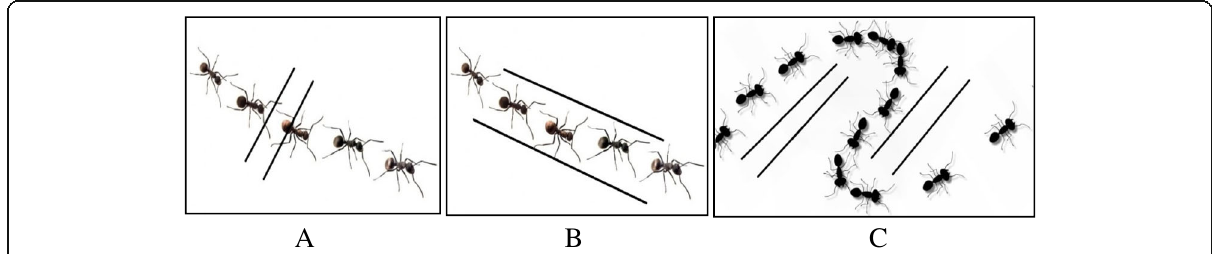
Fig. 4 Scenarios in the ant-rout experiment. Three scenarios of the ‘ ant-rout ’ experiment for predicting rains (parallel lines are artificially constructed ditches). a Ants cross ditches, indicating the coming of drought. b Ants go through ditches, indicating there will be good rain. c Ants going in roundabouts or zigzags to avoid ditches, indicating it will be